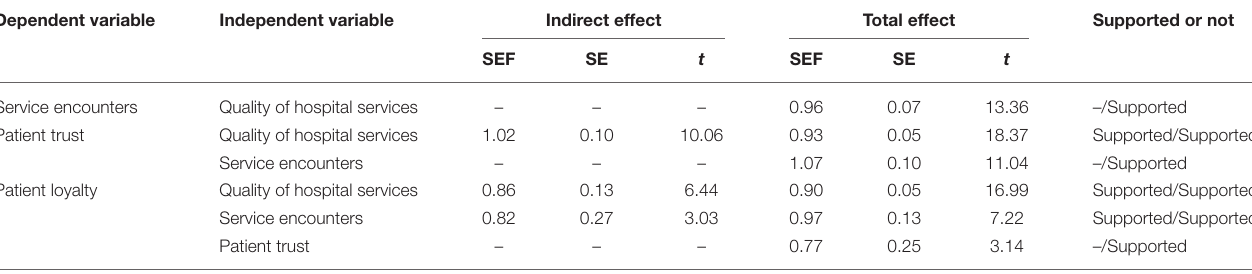
TABLE 12 | Analysis of indirect effect and total effect ( n = 483).